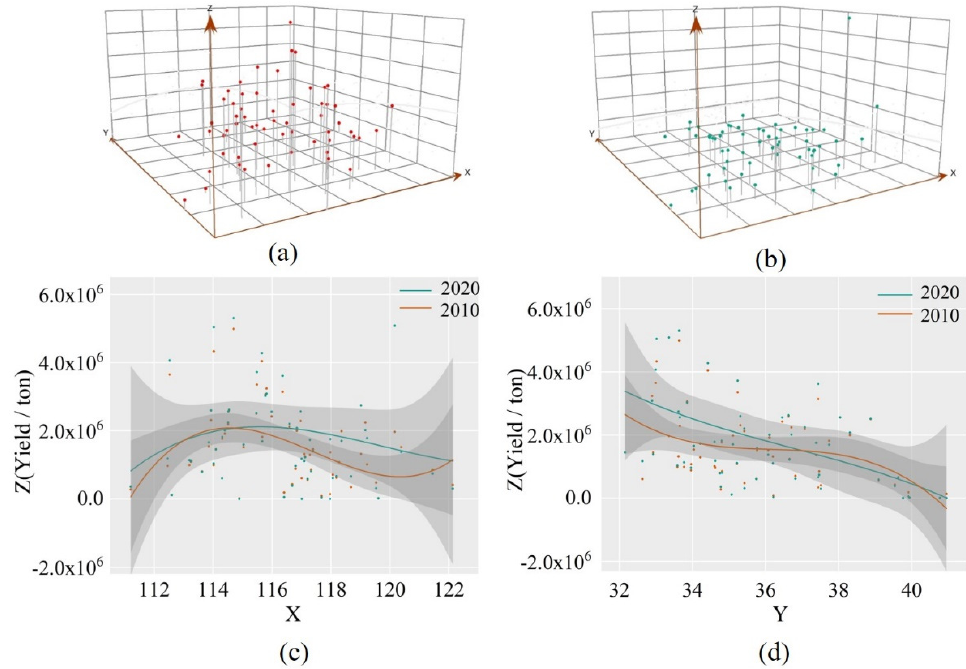
Figure 6. Spatial trend analysis of wheat production in the HHH City. ( a ) The spatial trend of wheat production in 2010. ( b ) the spatial trend of wheat production in 2020. ( c ) trends in wheat yield along the x-axis. ( d ) trends in wheat yield along the y-axis.